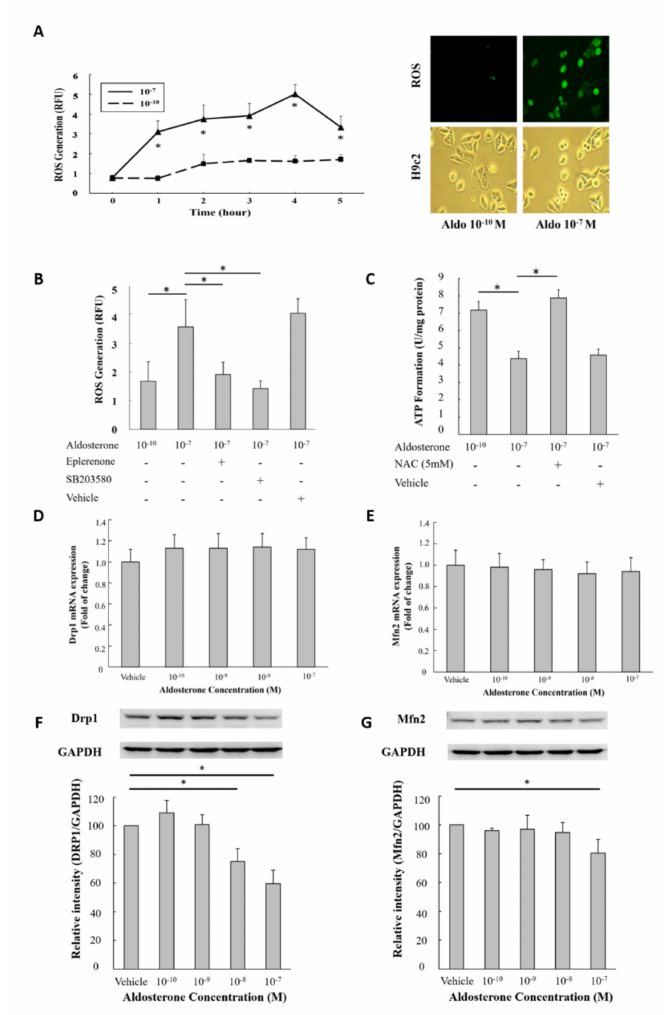
Figure 3. The MAPK/p38 signal pathway was associated with ROS production in aldosterone-treated H9c2 cells. ( A ) Aldosterone-induced ROS production in H9c2 cells. H9c2 cells were treated with 10 − 7 and 10 − 10 M aldosterone, and ROS regeneration was detected by reading the relative fluorescence from 0 to 5 h. The ROS fluorescence image of H9c2 cells treated with 10 − 7 and 10 − 10 M aldosterone at 45 min. The cell morphology under a light microscope was also examined; magnification × 400. ( B ) H9c2 cells were treated with 10 − 7 M eplerenone, 5 µ g/mL SB203580 or vehicle (equal volume of DMSO) for 1 h prior to 10 − 7 M aldosterone treatment. After 1 h, ROS regeneration was detected by reading the relative fluorescence. ( C ) H9c2 cells were treated with 5 mM NAC (antioxidant, N– acetyl–L–cysteine) or vehicle (equal volume of ddH2O) for 1 h prior to 10 − 7 M aldosterone treatment. After 72 h, the ATP formation capability was determined using a Seahorse XF–24 extracellular flux analyzer. ( D , E ) The effects of aldosterone on fission (Drp1) and fusion (Mfn2) mRNA expression in H9c2 cells. H9c2 cells were treated with different concentrations of aldosterone (vehicle, 10 − 10 , 10 − 9 , 10 − 8 and 10 − 7 M) for 72 h. mRNA expression of Drp1 and Mfn2 were determined using quantitative RT-PCR. ( F , G ) The effects of aldosterone on fission (Drp1) and fusion (Mfn2) protein in H9c2 cells. H9c2 cells were treated with different concentrations of aldosterone (vehicle, 10 − 10 , 10 − 9 , 10 − 8 and 10 − 7 M) for 72 h. Drp1 and Mfn2 were determined using Western blot analysis. * p < 0.01 compared between the two groups indicated by the line